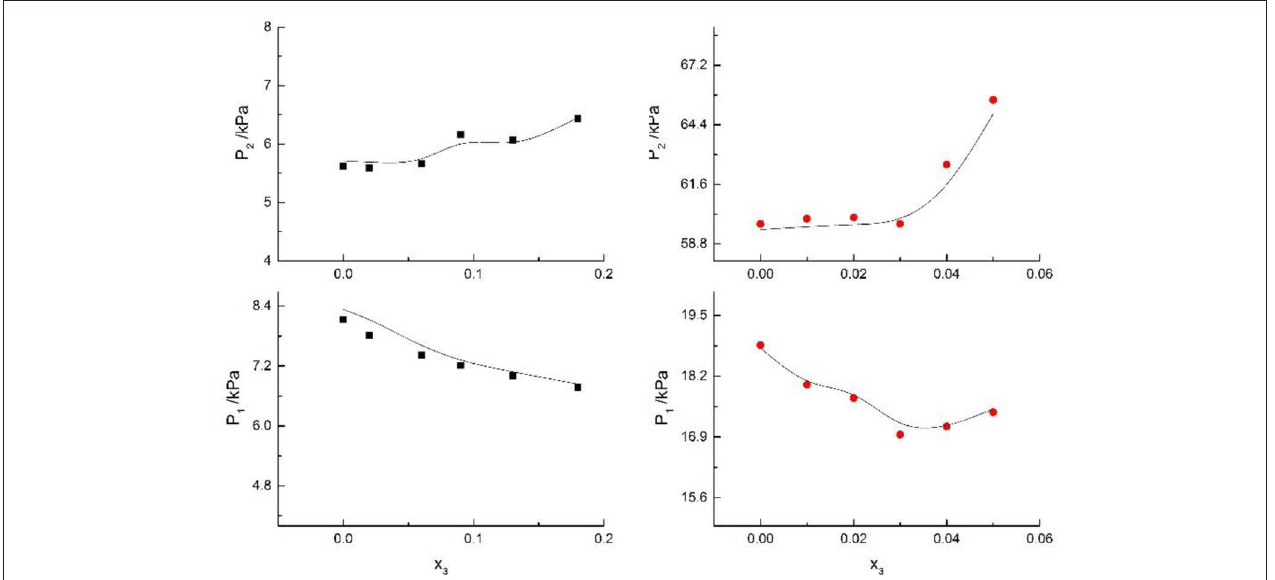
FIGURE 9 | Correlation of VLE data for H2O(1) + CH3OH(2) + KBr(3) system. Filled symbols ( (cid:4) x2 = 0.08 and T = 316K; • x2 = 0.46 and T = 341K) indicate experimental data; curves indicate correlation of the model.